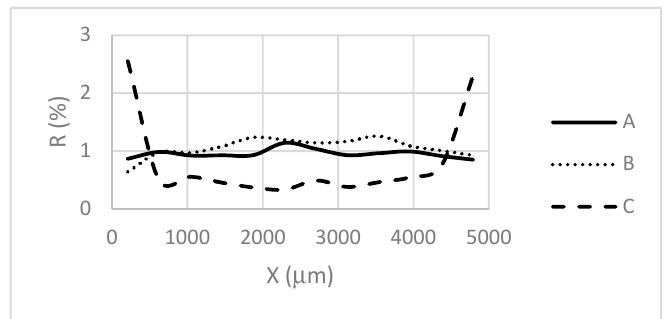
Figure 6. Deposition of the cells along X axis of the substrates.